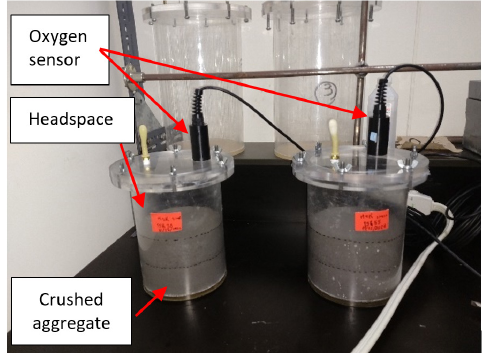
Figure 5. Simplified protocol for determining the potential reactivity of iron sulfide-bearing aggregates as presented in Annex P of CSA A23.1:19 [56] (modified from the original version proposed by Rodrigues et al. [48]. Limit values (in red) still need to be validated.